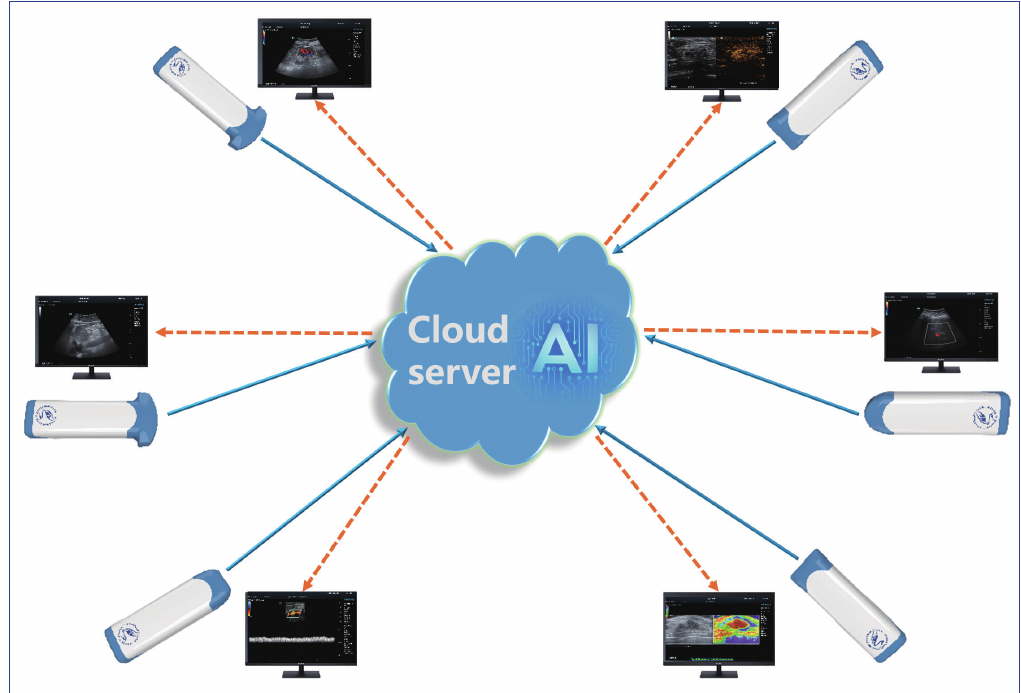
Figure 2 A diagram demonstrates a concept of distributed cloud-based ultrasound device and